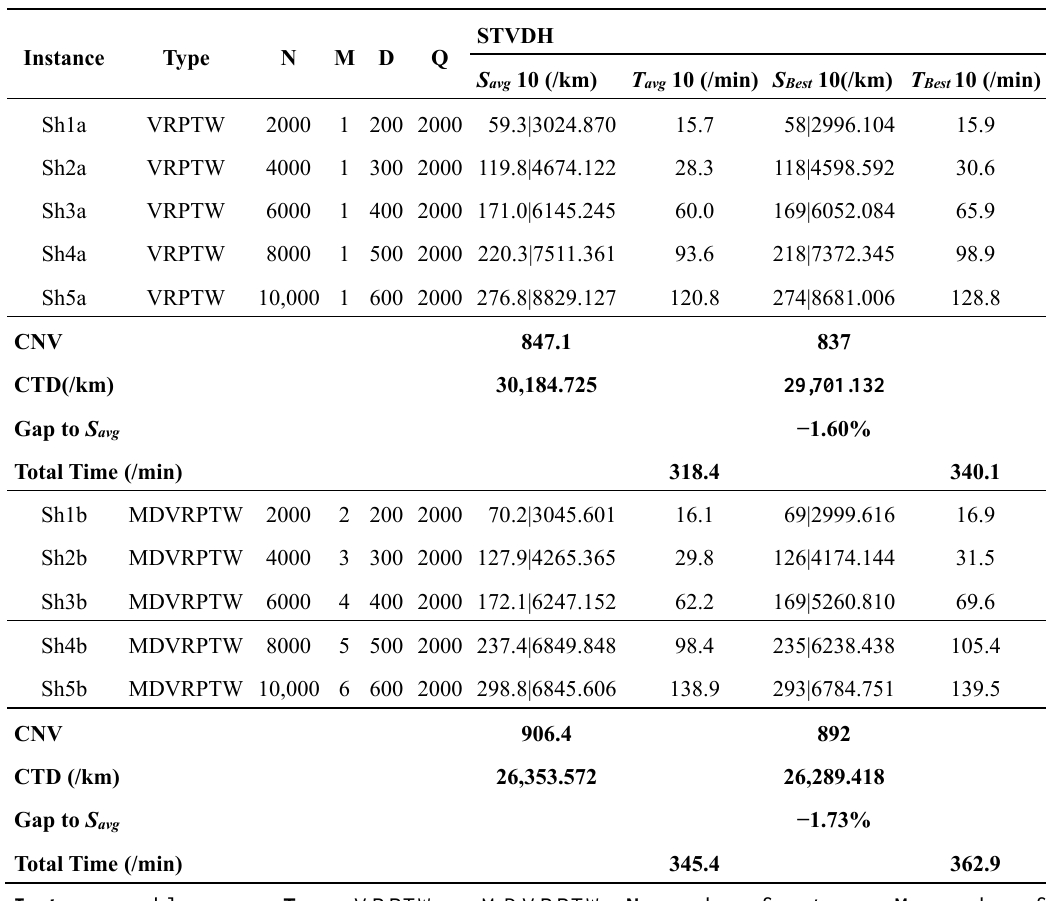
Table 4. Results from the large-scale VRPTW and MDVRPTW instances in Shanghai, China.